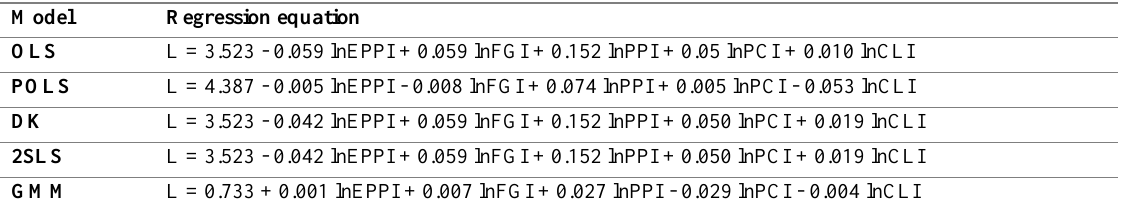
Table 7: Comparative coefficient analysis of the empirical